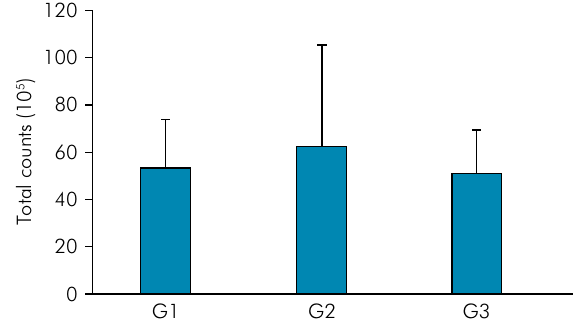
Figure 2. Total bacterial counts (×10 5 ) of biofilms formed on titanium discs surfaces of G1, discs with machined surface; G2, discs produced via the additive manufacturing of titanium with chemical treatment; and G3, discs produced via the additive manufacturing of titanium without chemical treatment. Results are expressed as means and SDs of three independent experiments in triplicate (n = 9). Kruskal–Wallis test revealed no significant differences among groups (p > 0.05).